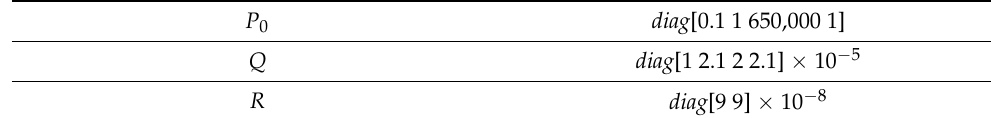
Table 3. Tuning parameters for the AEKF estimation model.